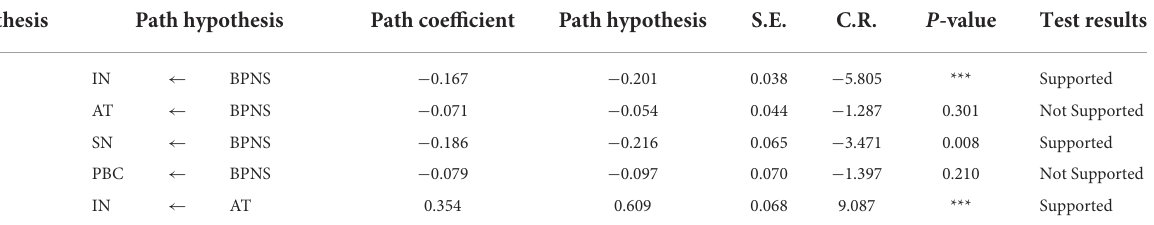
TABLE 6 Path coefficient of the research model.